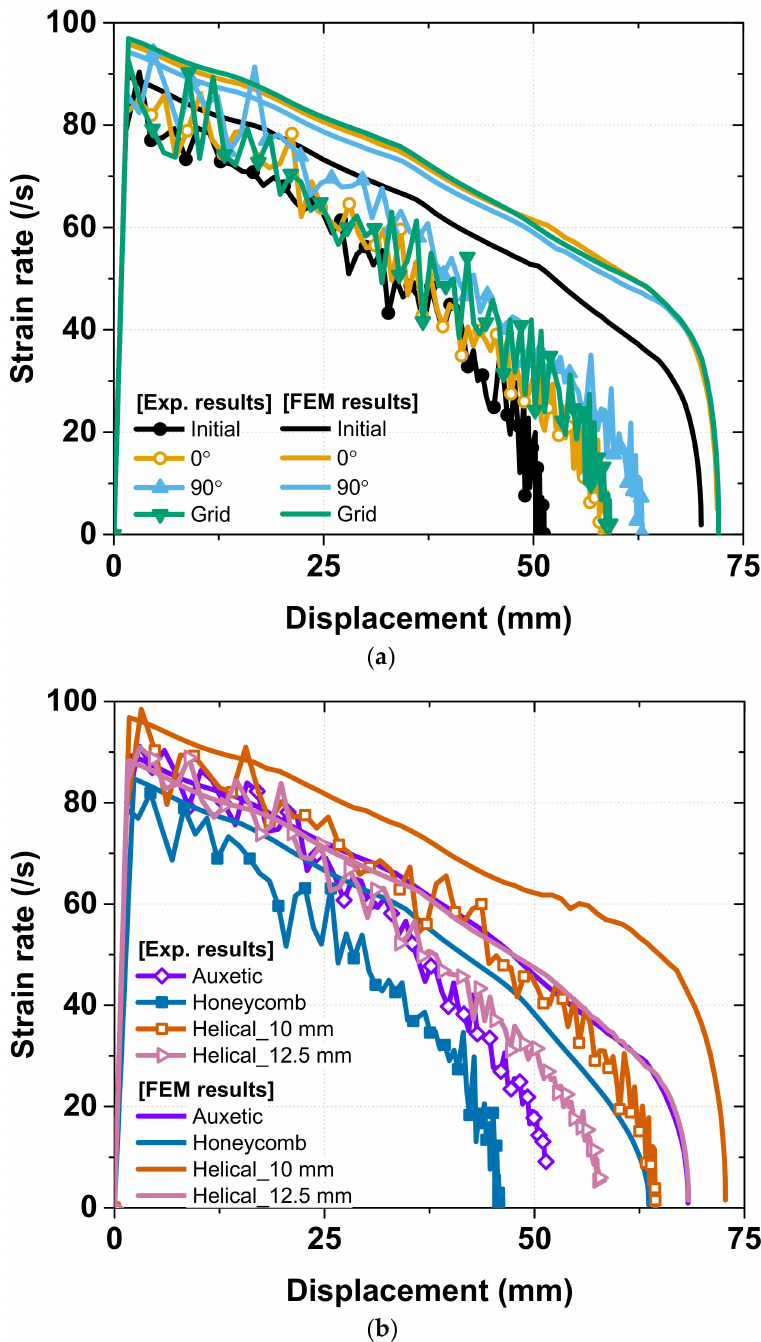
Figure 18. Comparing Strain rate between FEM analysis and Experiment: ( a ) Group 1: initial, 0 ◦ , 90 ◦ and grid; ( b ) Group 2: auxetic, honeycomb, helical with pitch of 10 mm and helical with pitch of 12.5